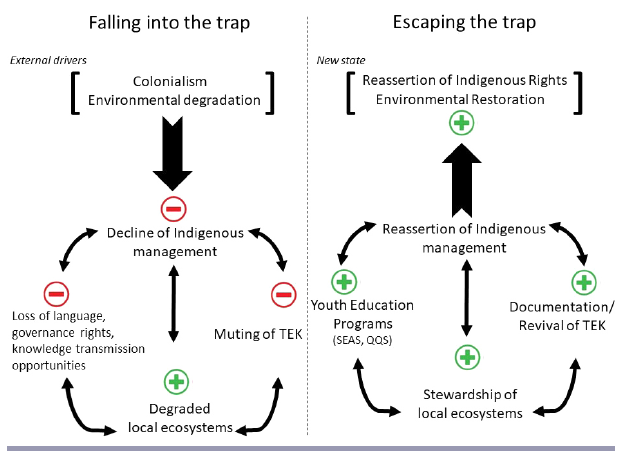
Fig. 2 . The social-ecological trap. On the left, this figure depicts the forces that drove partnering First Nations on B.C.’s Central Coast into a trap, and the interacting forces that perpetuate the trap. On the right, positive interactions generated within First Nations highlight ways to escape the